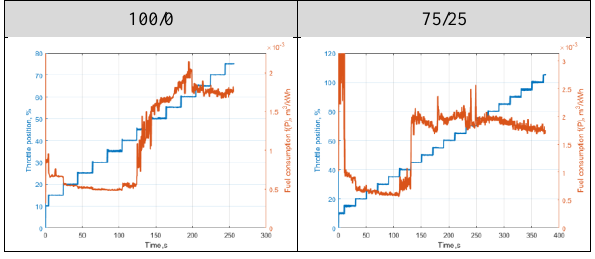
Fig. 11. Course of unit fuel consumptions Its lowest values were recorded in the area of the high- est electric power and they amount to 0.48 m 3 /kWh for 100 % methane content and exceed 0.6 m 3 /kWh for gas contain- ing less than 60% methane (Fig. 12). Fig. 9. Concentration of CO in the exhaust gases at supply of different gas mixture